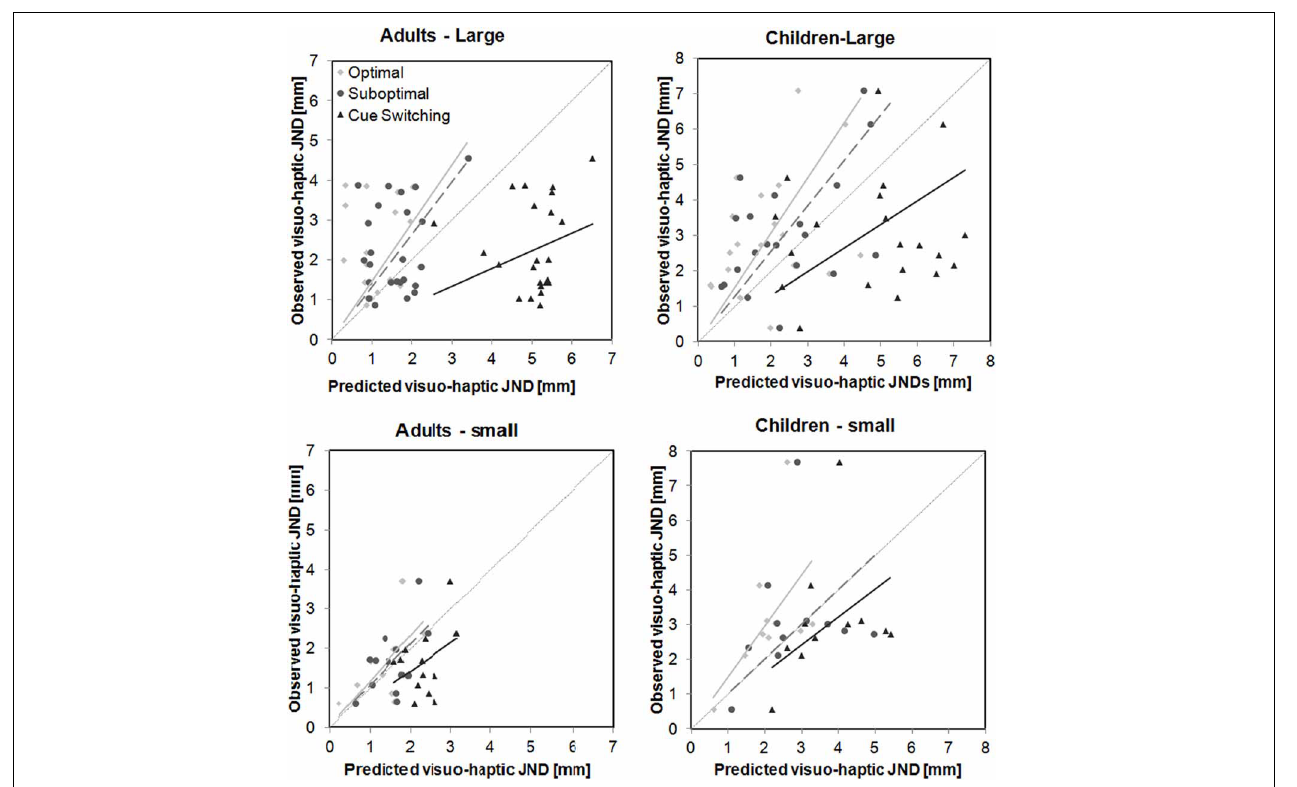
FIGURE 5 | Predicted individual visuo-haptic JND values against observed values as a function of Intersensory discrepancy and Age group. Thick lines represent linear regressions with the constant being set